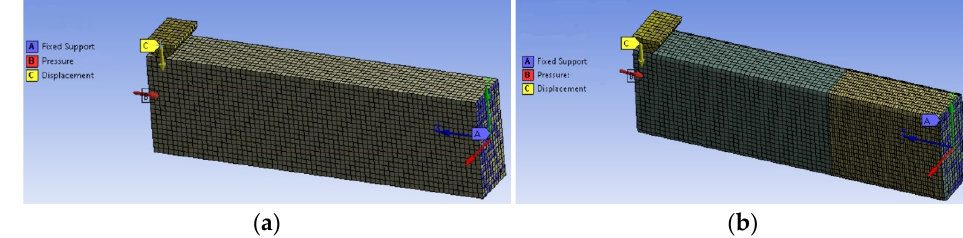
Figure 2. Boundary conditions and loading of ( a ) unretrofitted and ( b ) retrofitted columns.